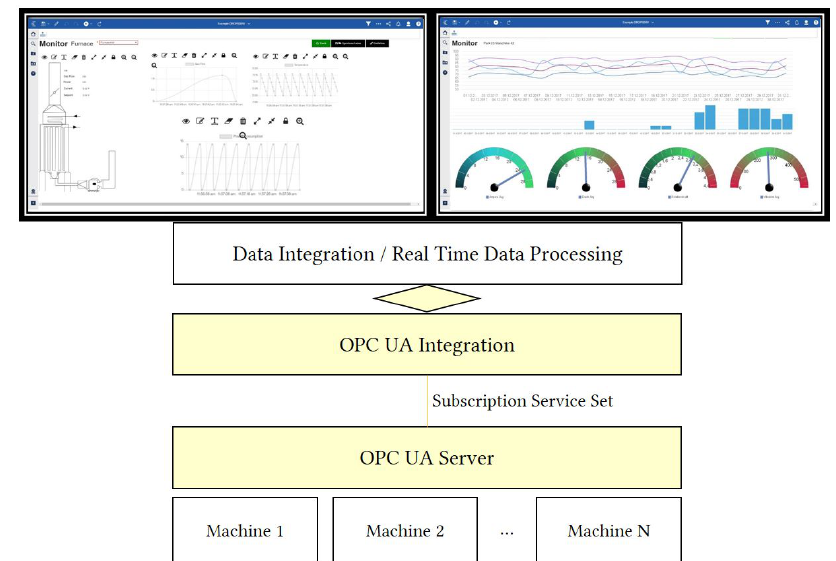
Figure 4. The Digital Control Room: Integrating the OPC UA